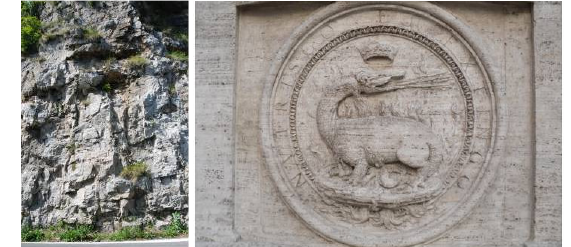
Figure 4. Examples of good calibration objects.